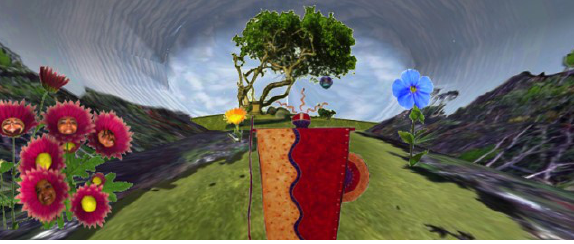
Figure 1 | Digital scents represented the character in